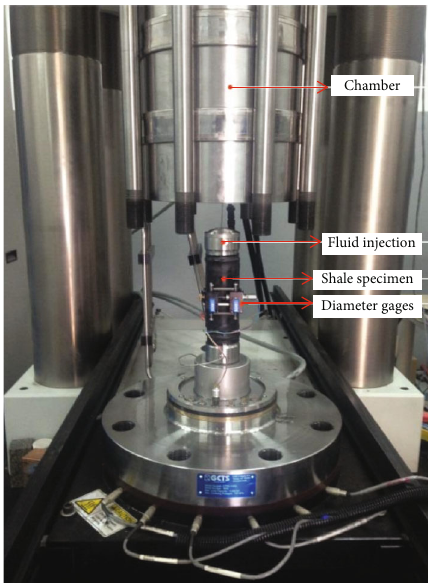
Figure 2: Shale specimen installed in the triaxial compression